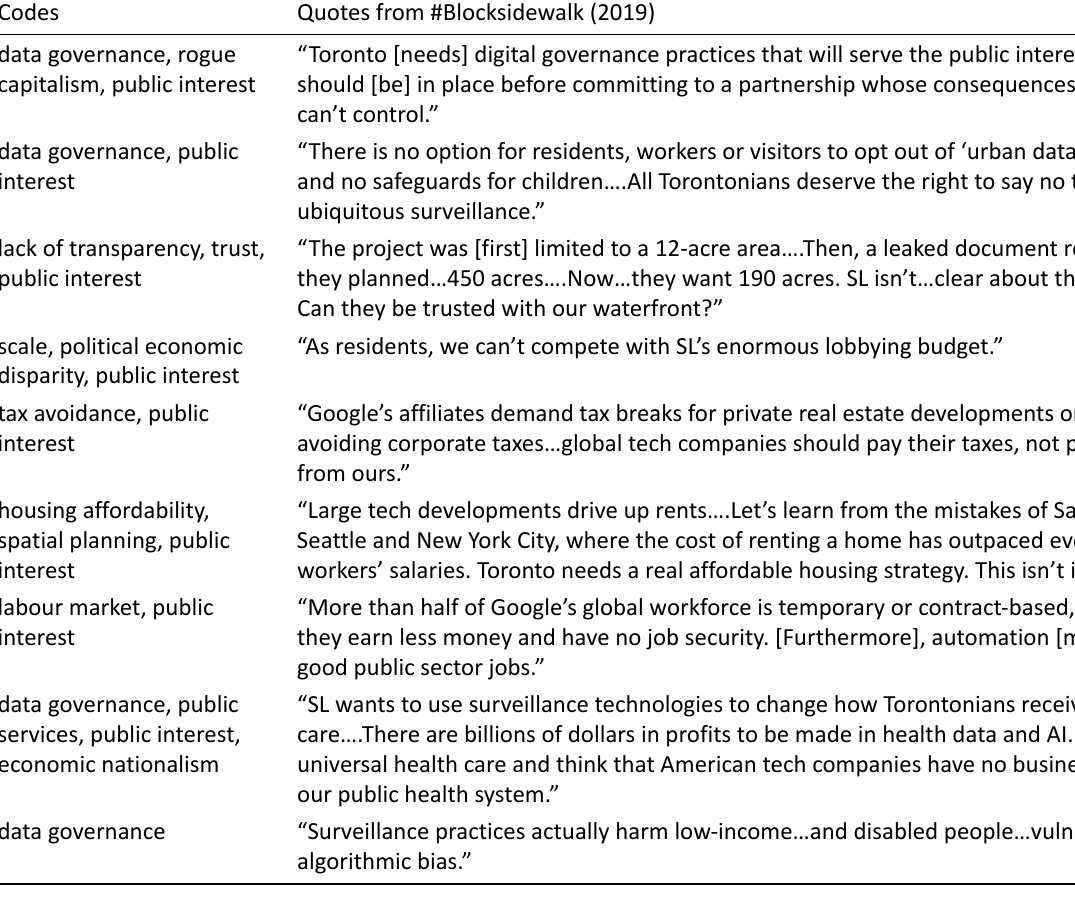
Table 1. Key points of criticism concerning the Quayside project. Source: Blocksidewalk (2019). Codes Quotes from #Blocksidewalk